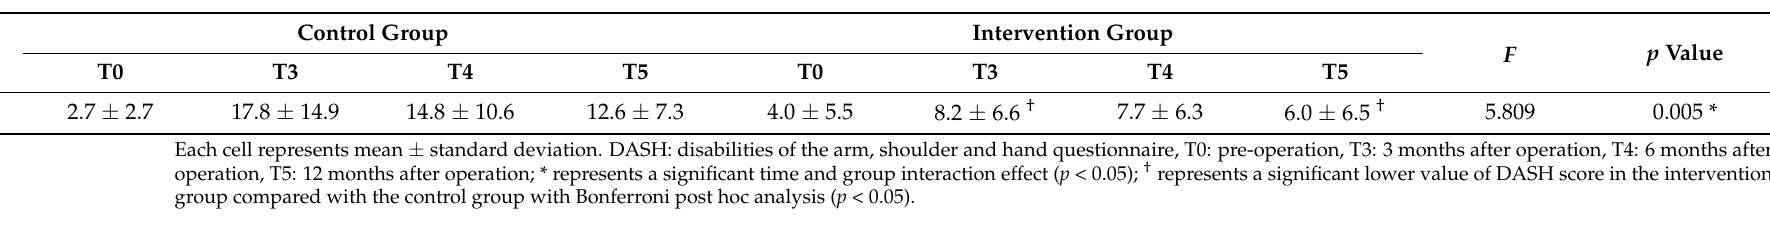
Table 4. The values in the 36-Item Short-Form Health Survey (SF-36 score). Control